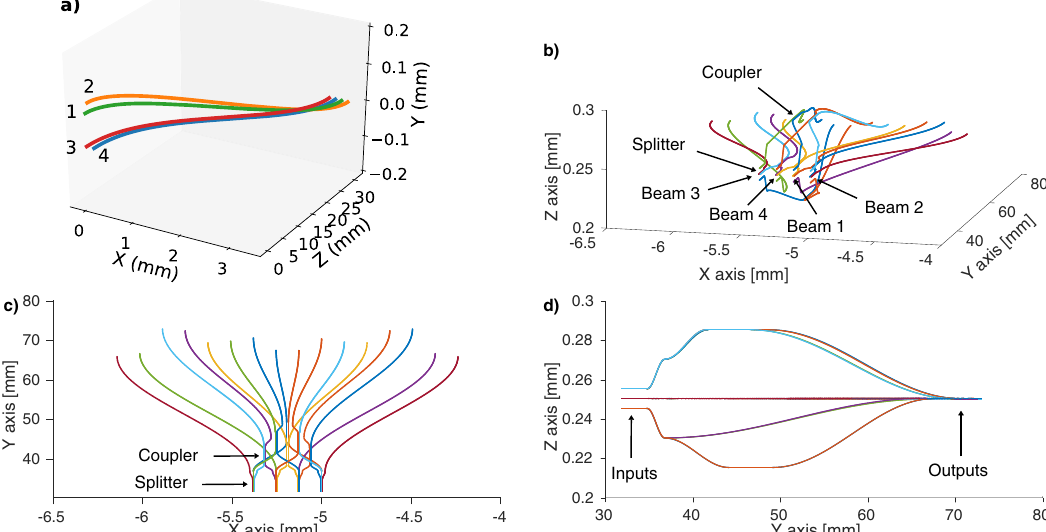
Fig. 2 Schematics of the integrated-optics chip. a Schematics of the pupil remapper of the chip, coherently transforming the 2D con fi guration of the inputs (on the left) matching the desired pupil sampling pattern into a 1D con fi guration (on the right). The waveguide paths have been optimised to match their optical path lengths despite their different routes. The green waveguide is associated with beam 1, orange with beam 2, red with beam 3 and blue with beam 4. b Perspective view of the beam combiner of the chip. c Plan view in which light propagates from the 4 inputs at the bottom towards the top, encountering 4-way splitters and codirectional couplers. d Right-side view of the chip showing the locations of the inputs and the outputs. The inputs, outputs, splitters and couplers are indicated on the ( b – d ) diagrams. The axis scale proportions in all the schematics differ for clarity in the